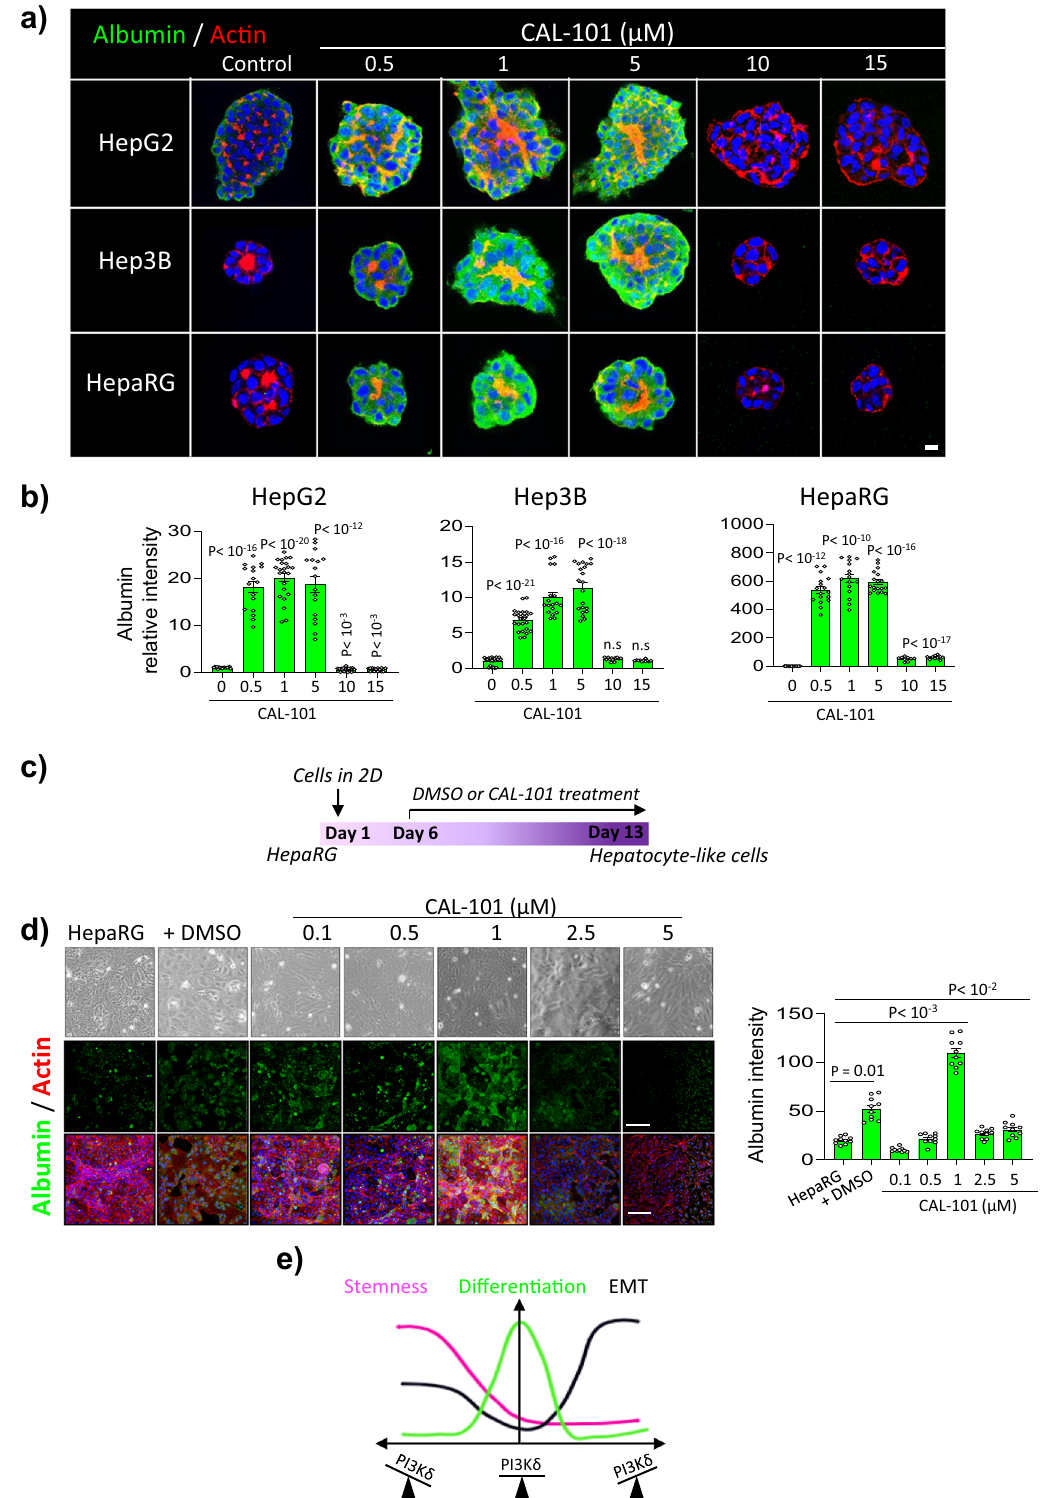
Fig. 7 The inhibition of PI3K δ activity increases albumin protein level in different hepatic cell lines. a Immuno fl uorescence staining for Albumin (green), actin micro fi laments using phalloidin (red) and nuclei (blue) in HepG2, Hep3B and HepaRG cells plated in 3D cultures for 6 days and treated or not with the PI3K δ speci fi c inhibitor (CAL-101) at different doses. Scale bar: 10 µ m. b Quanti fi cation of albumin relative intensity in the different cell lines treated or not with CAL-101 at different doses. c Experiment plan for HepaRG differentiation using DMSO or CAL-101. d Immuno fl uorescence staining for Albumin (green), actin micro fi laments using phalloidin (red) and nuclei (blue) in HepaRG cells treated with DMSO or CAL-101 at different doses after 7 days of treatment. Scale bar: 100 µ m. Quanti fi cation of albumin relative intensity in HepaRG within the different conditions above. e Proposed PI3K δ dependant pathway discriminating EMT from stemness. All values are expressed as mean ±